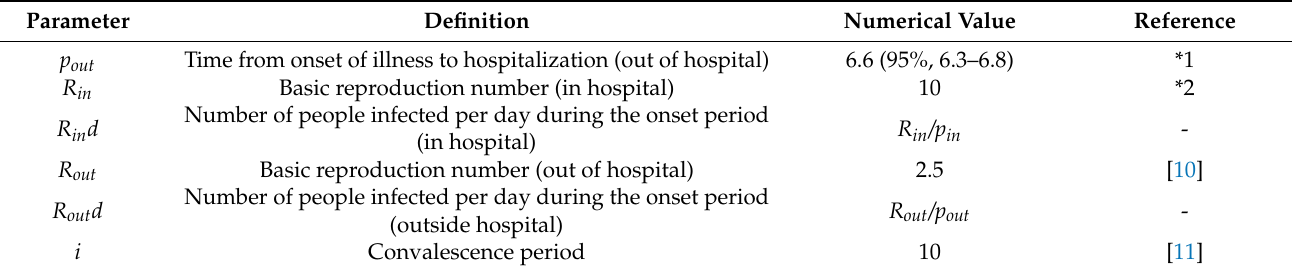
Table 1. Parameters for simulation.